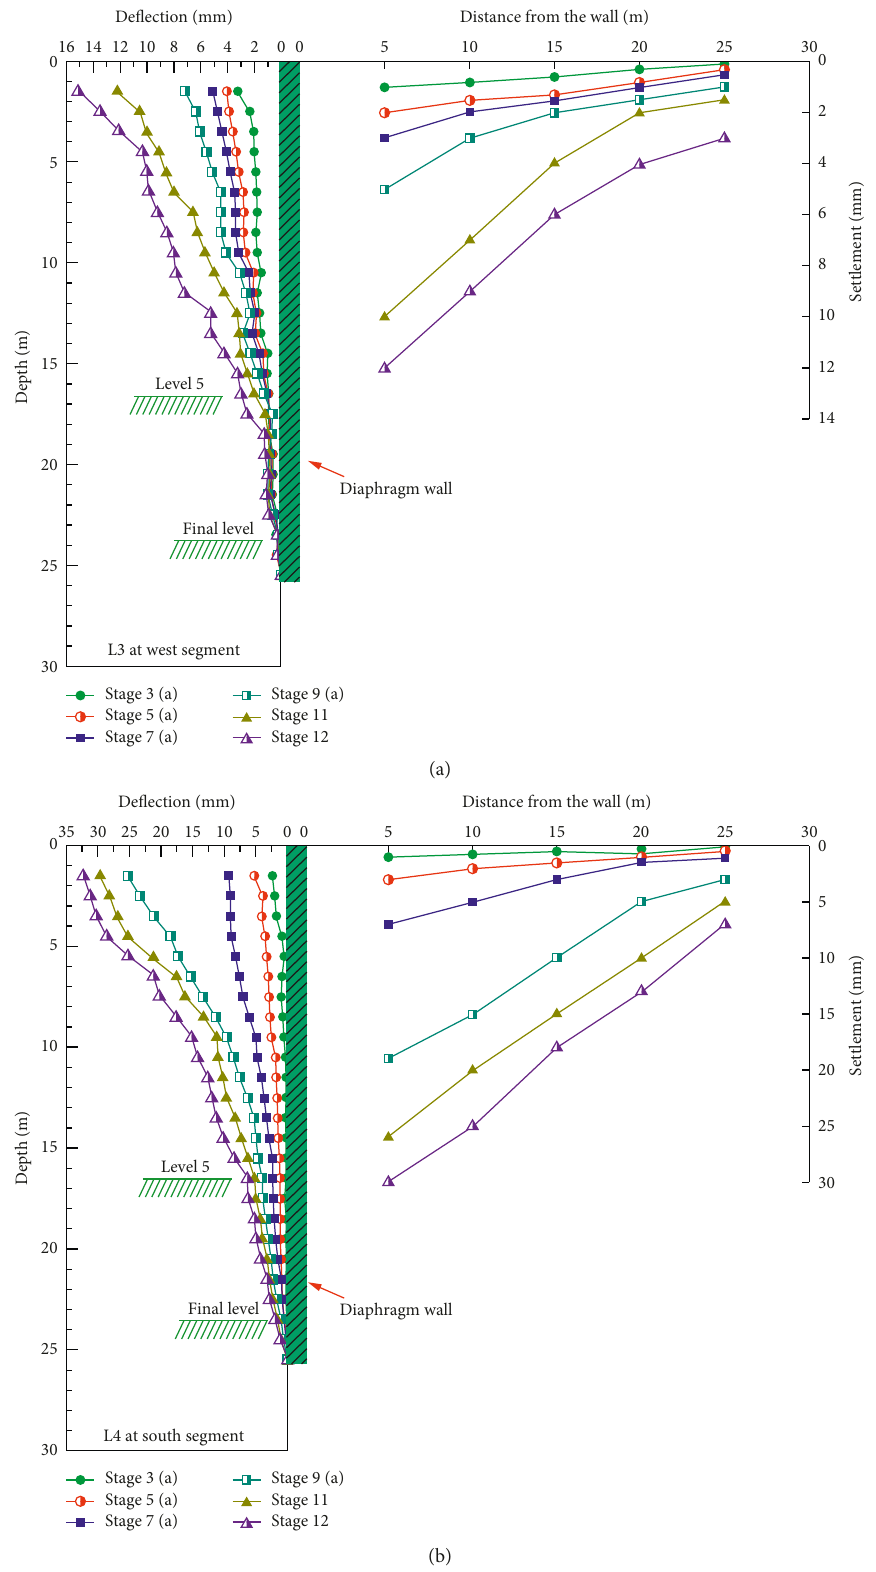
Figure 11: Lateral wall deflection and ground settlement. (a) L3 at the west segment. (b) L4 at the south